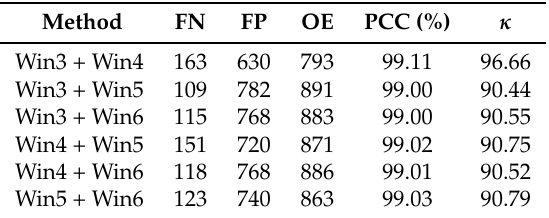
Table 6. Evaluation values of different sizes of fused blocks of the Farmland C data set.